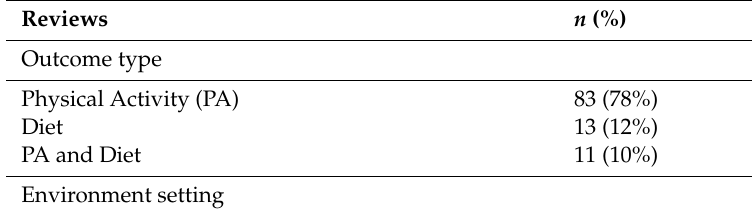
Table 3. Selected characteristics of the review papers included in the qualitative analysis ( n =